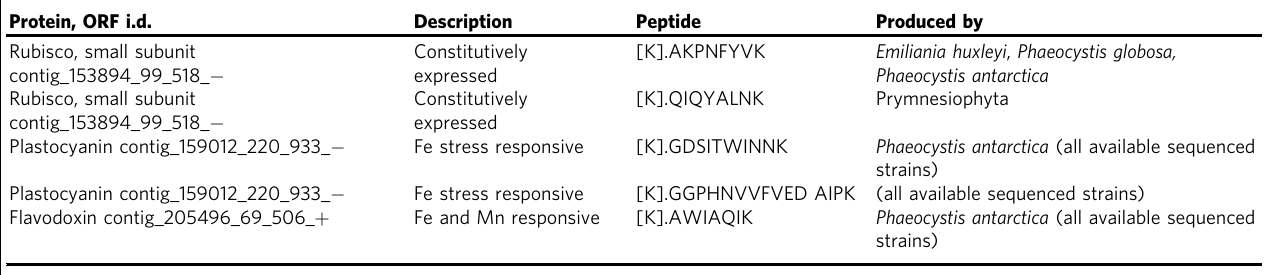
Table 1 Peptides for targeted selected reaction monitoring analyses Protein, ORF